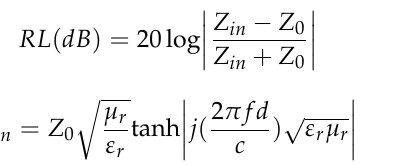
Figure 6. TEM pattern (insert in ( a )), HR-TEM images ( a – f ) and SAED patterns ( g ) of S2. To evaluate the EMW absorption capability of the samples, the reflection loss (RL) values were calculated by using the following equations [44]: